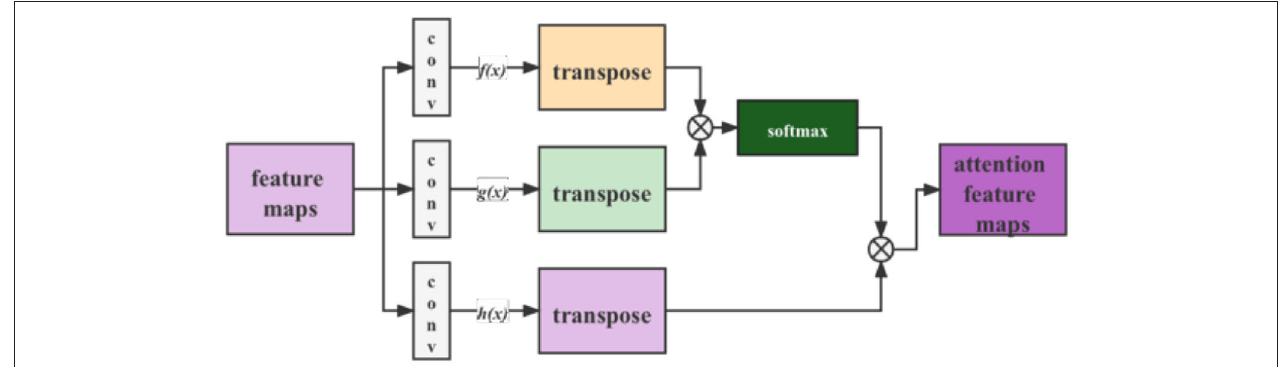
FIGURE 5 | Flow chart of